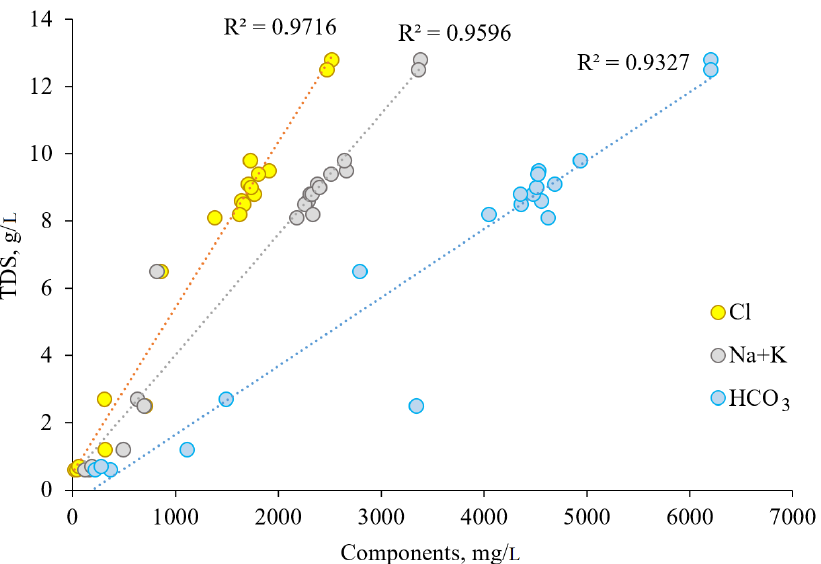
Figure 6. Relationship between TDS and the content of main ions in the studied water, and their correlation coefficients (R 2 ).